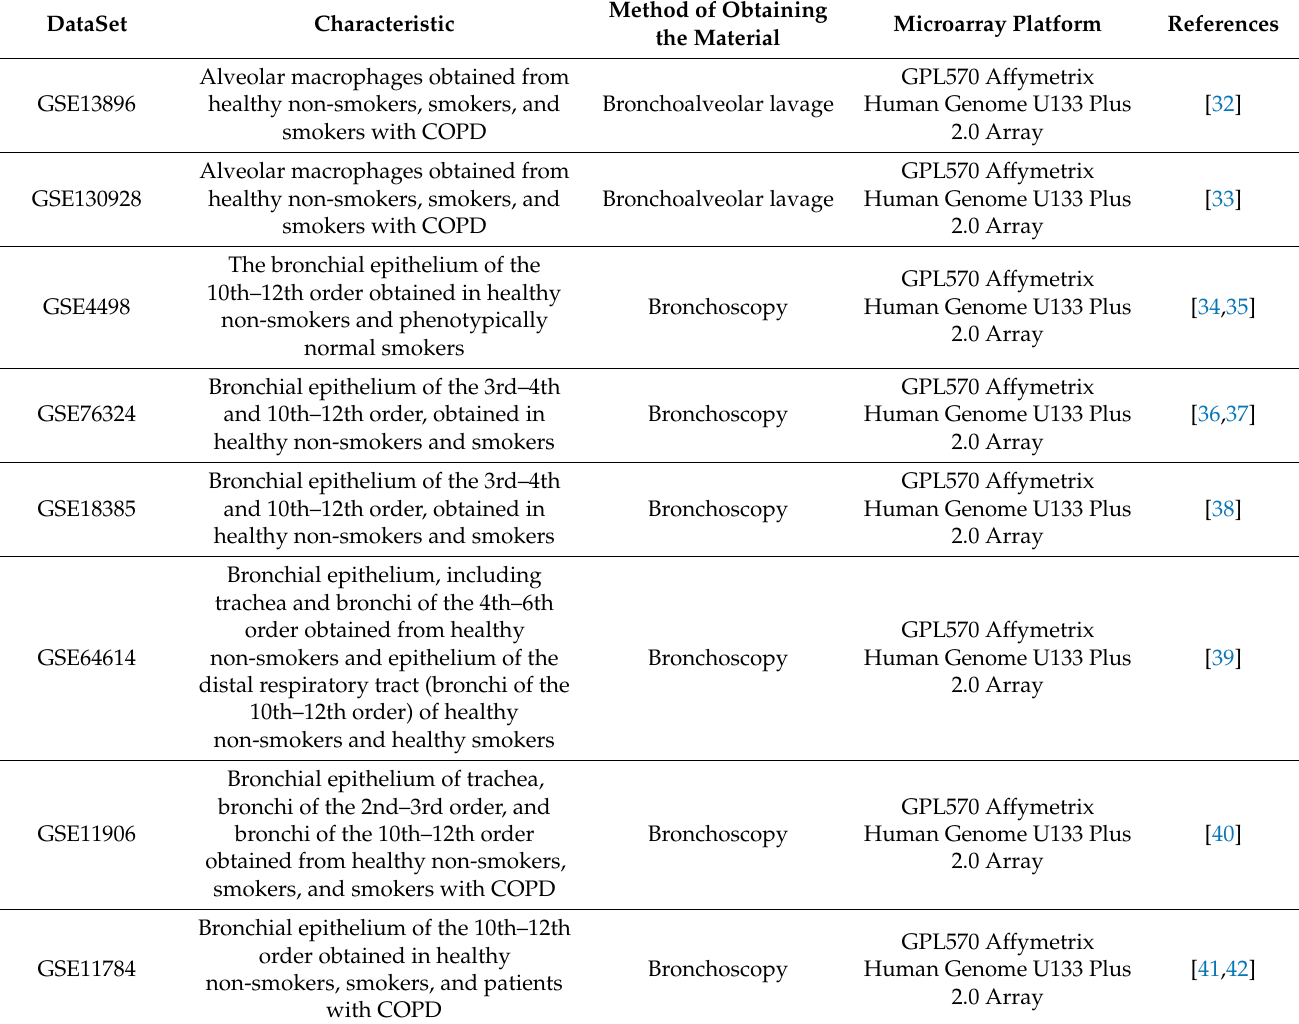
Table 1. Characteristics of the analyzed GEO